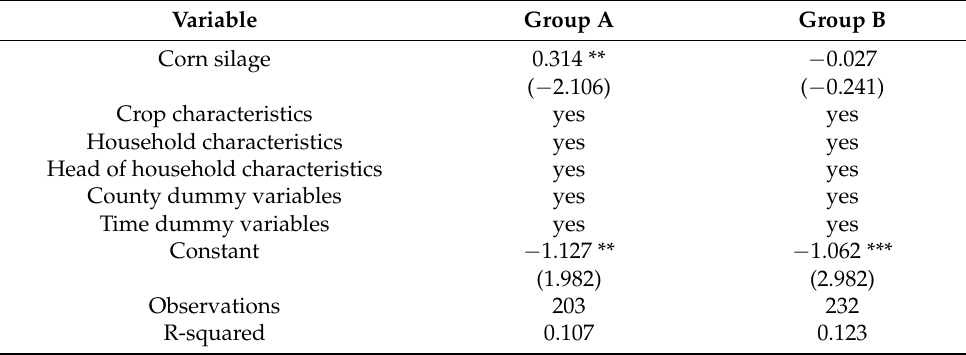
Table 6. Estimated effects of corn silage on income at different distances to dairy farms. Variable Group